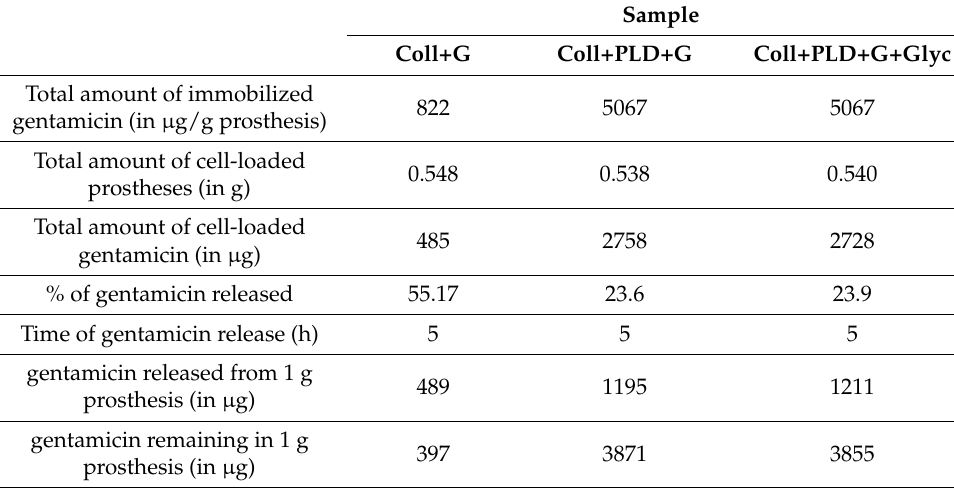
Table 3. Parameters of gentamicin release from tested